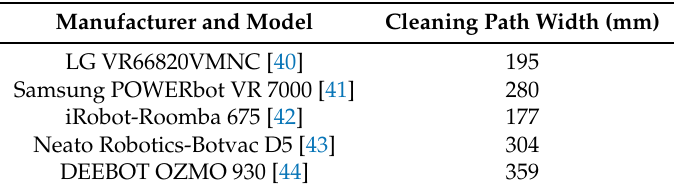
Table 2. Inlet Size of some common cleaning robots.